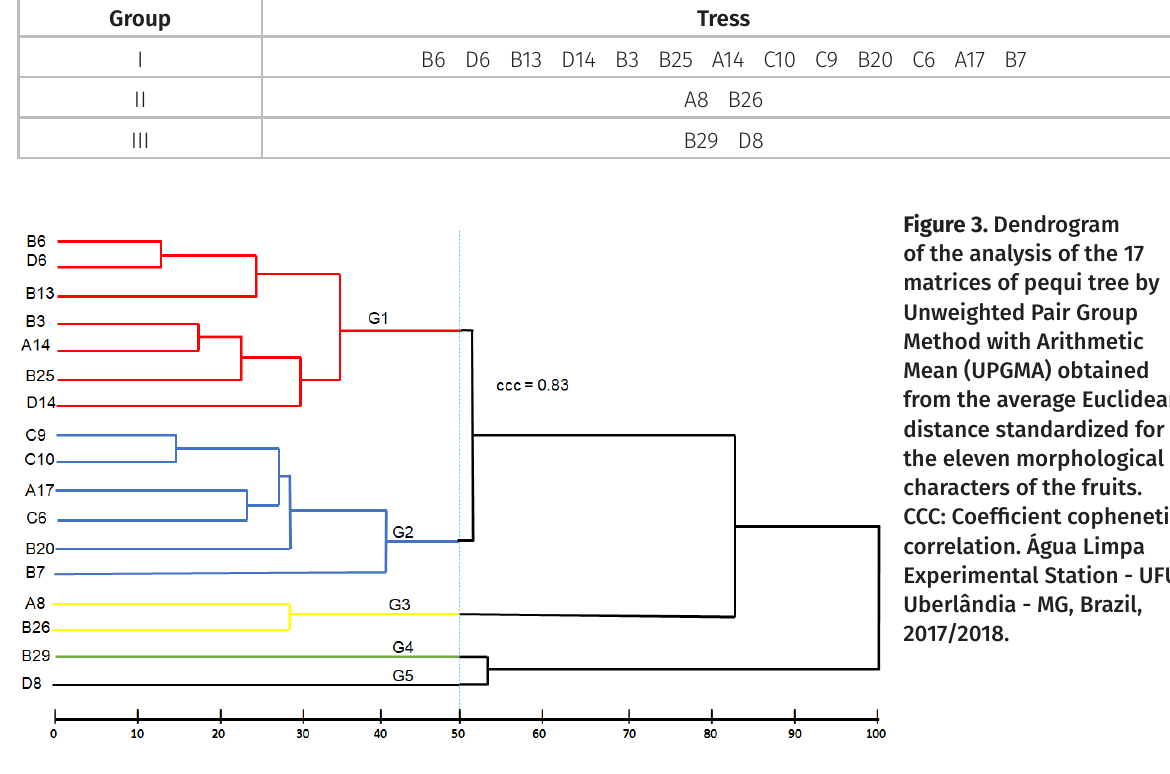
Table III. Tocher grouping obtained from the average Euclidean distance standardized on 17 trees for the 11 characters of the fruits, produced at Água Limpa Experimental Station - UFU, Uberlândia - MG, Brazil, 2017/2018.